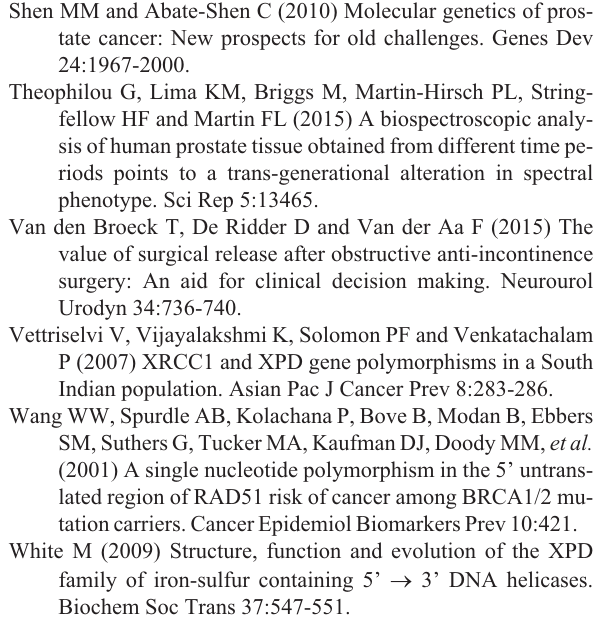
ferent socio-economical and life style groups. Table S2 - Frequencies of the combined genotypes in 110 prostate cancer patients and 200 controls. Table S3 - Allelic and genotype frequencies of